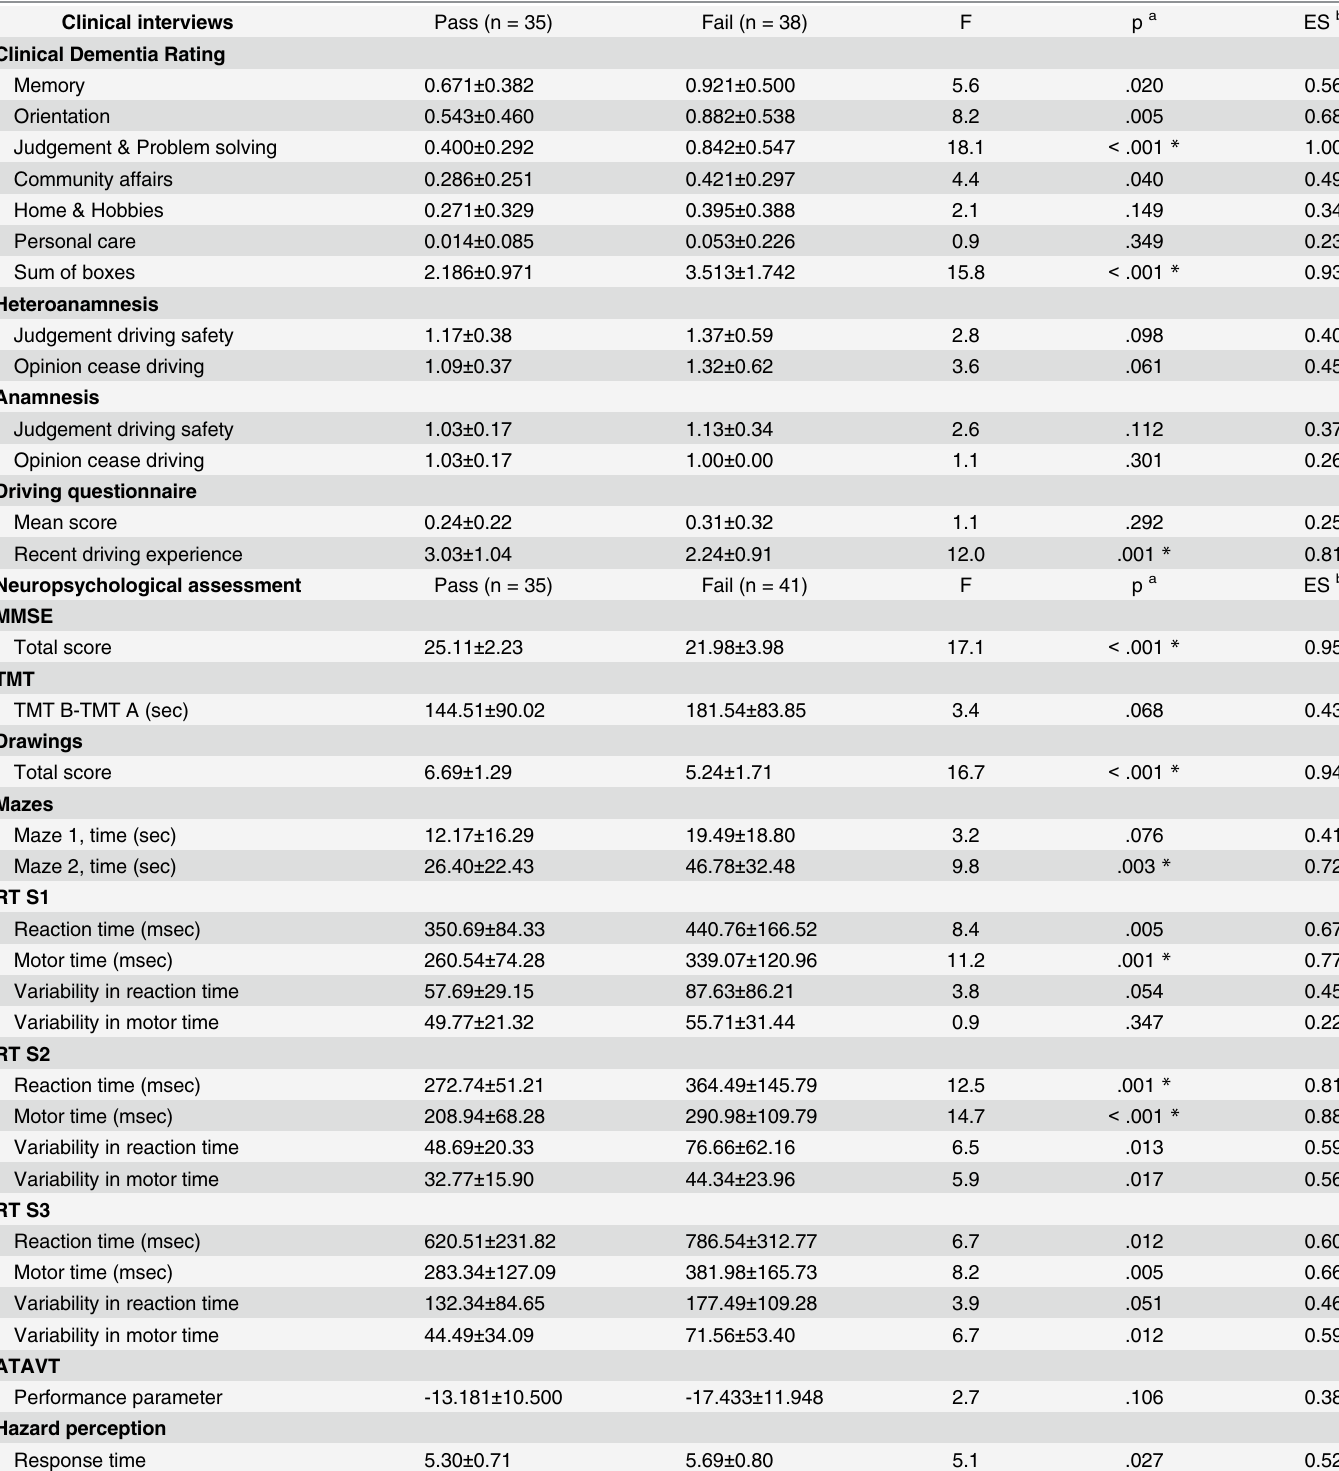
Table 3. Comparison of patients with Alzheimer ’ s disease (AD) who pass and patients with AD who fail the on-road test on clinical interviews, neuropsychological assessment, and driving simulator